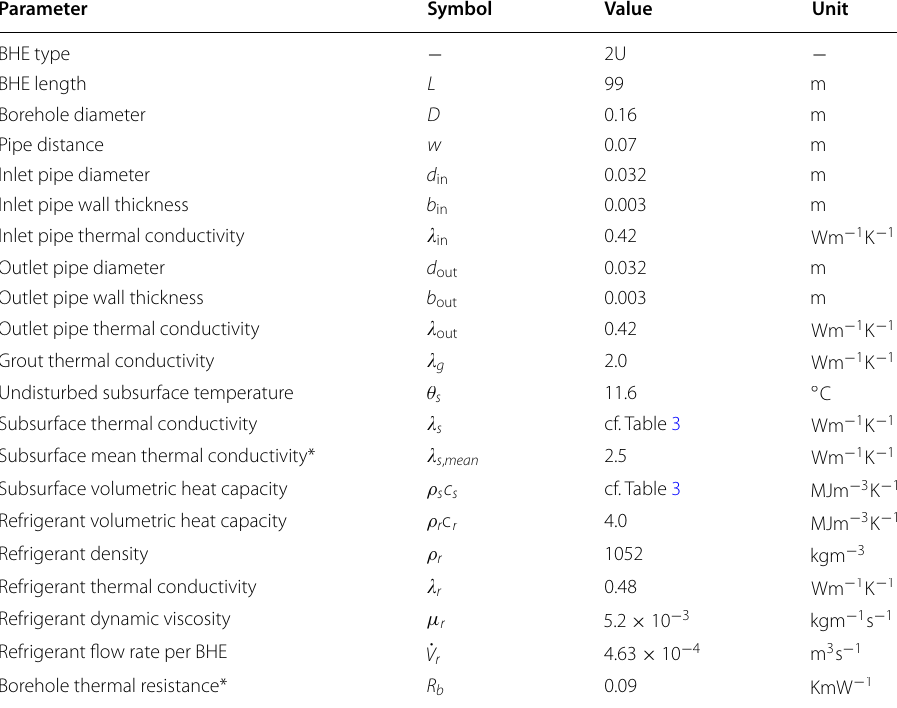
* Not used in the model, only for comparison purposes